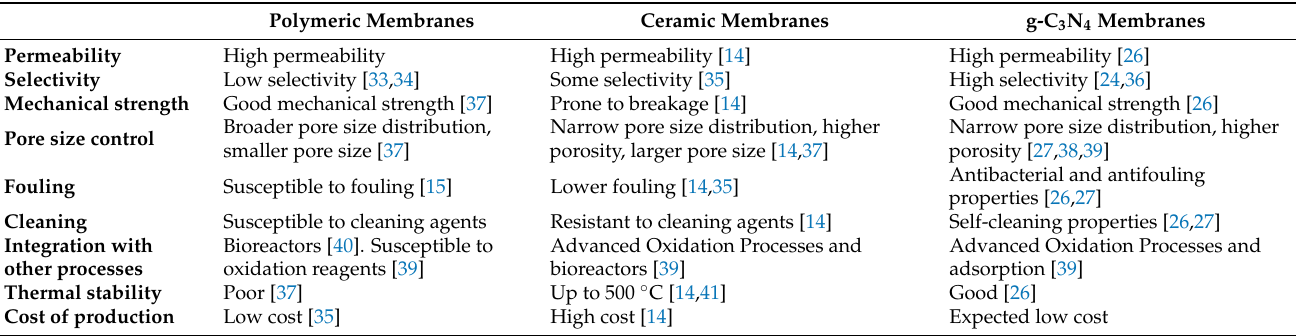
Table 1. Comparison between polymeric, ceramic and g-C 3 N 4